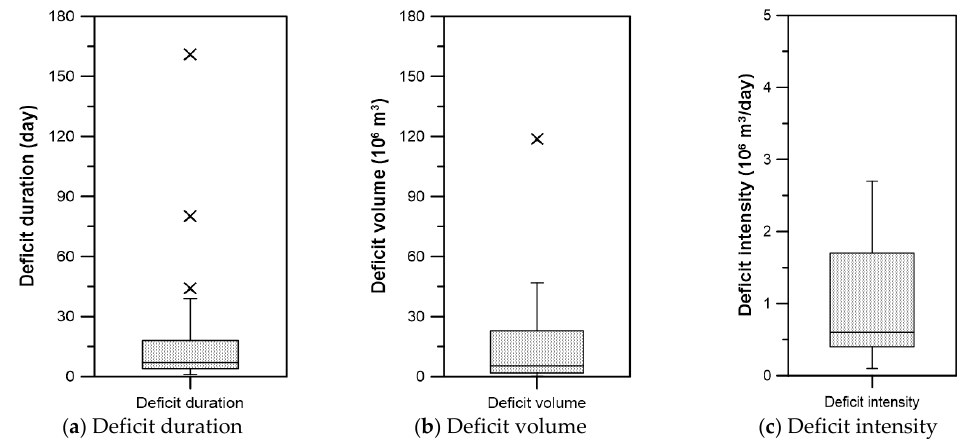
Figure 3. Box-plots of three components of water deficit events observed at the Namgang